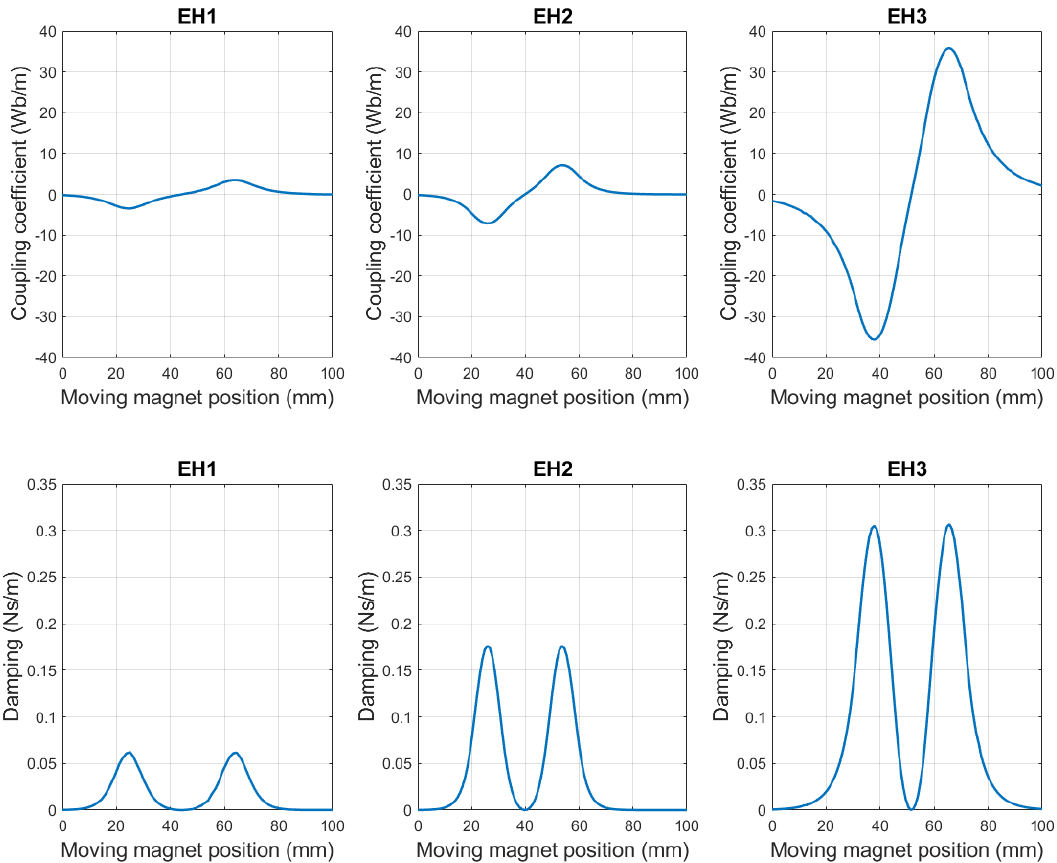
Figure 7. Electromagnetic coupling coefficient and damping curves.